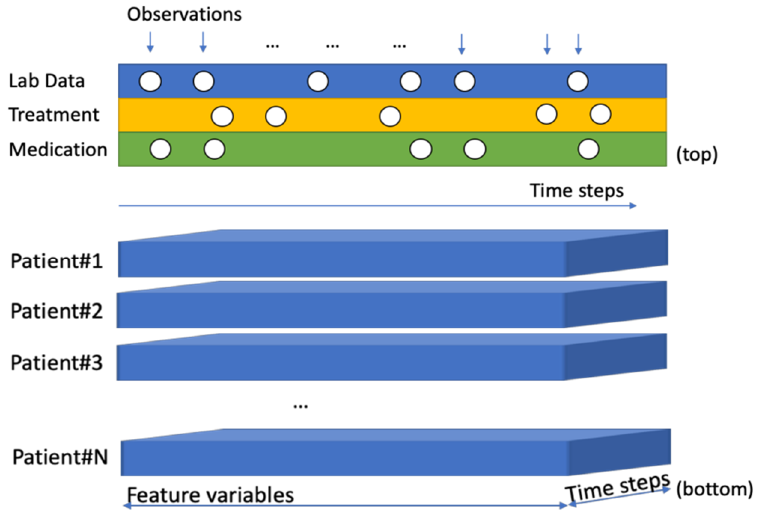
Figure 1. Irregularly collected events observations (top) 3D format input for serial data model (bottom) .